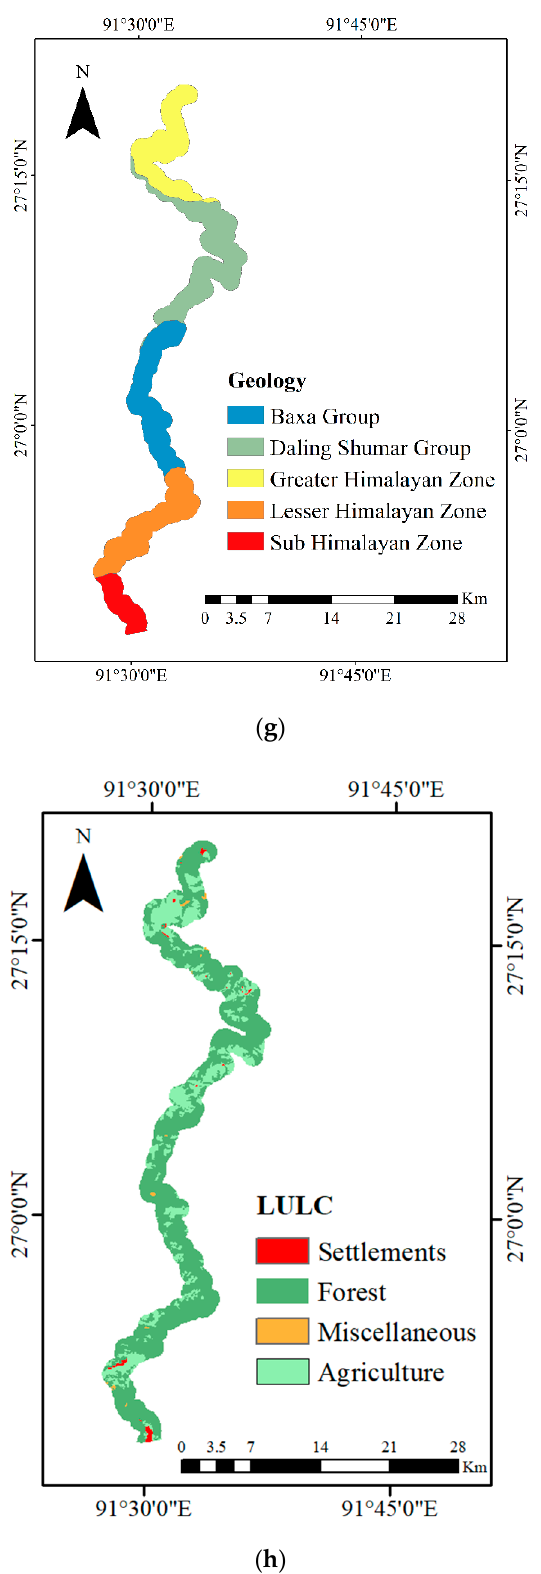
Figure 9. Landslide-conditioning factor maps: ( a ) slope, ( b ) elevation, ( c ) aspect, ( d ) mean daily rainfall, ( e ) proximity to road, ( f ) proximity to stream, ( g ) geology, and ( h ) land use and land cover (LULC).